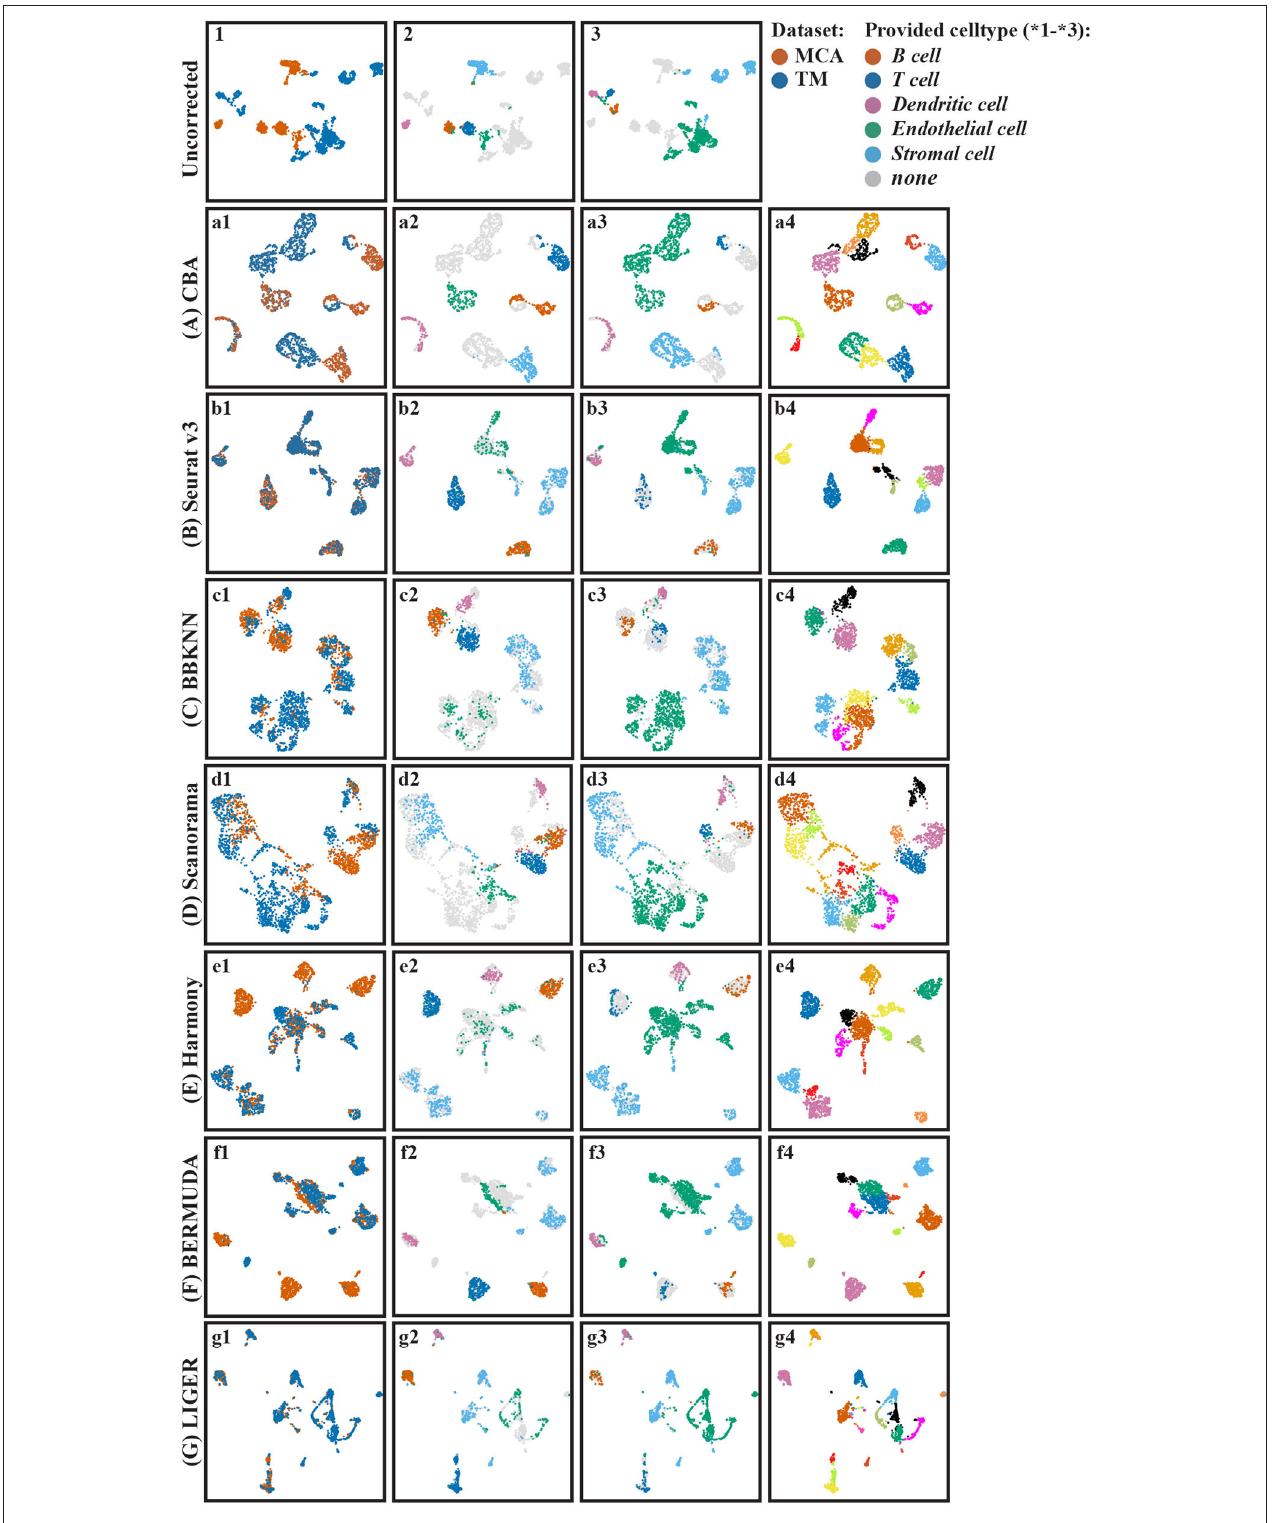
FIGURE 7 | UMAP visualization of different batch effect removal methods for the mouse lung cell datasets. (A–G) Show the different alignment methods: (A) CBA, (B) Seurat v3, (C) BBKNN, (D) Scanorama, (E) Harmony, (F) BERMUDA, and (G) LIGER. For each panel four color codings are shown again: 1) colored according to the batches, 2) colored according to provided clusters in batch one, 3) colored according to provided clusters in batch two, and 4) colored according to Louvain clusters.